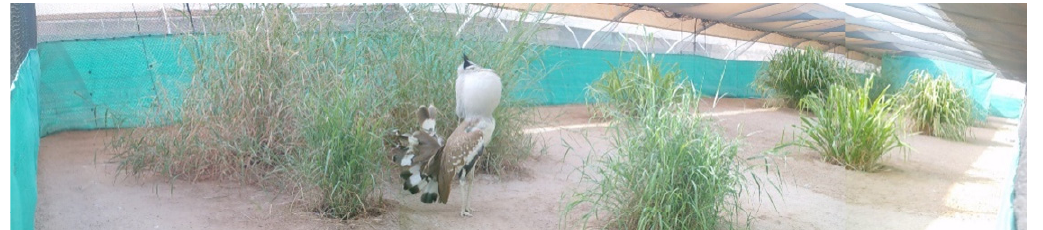
Figure A3. Male Arabian bustard displaying in an adult holding tunnel.